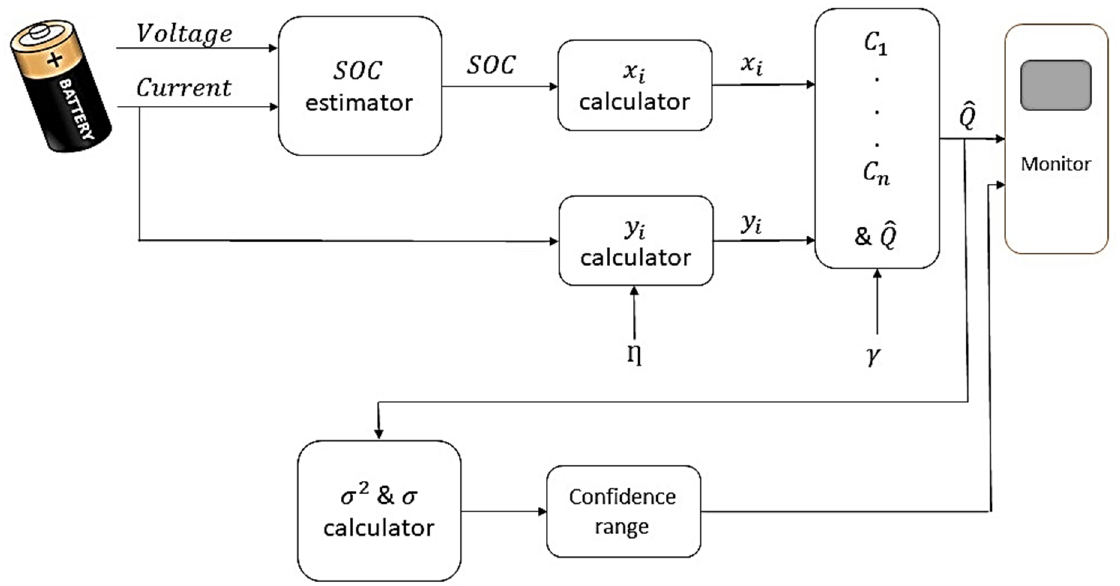
Figure 8. Total Q estimation diagram.